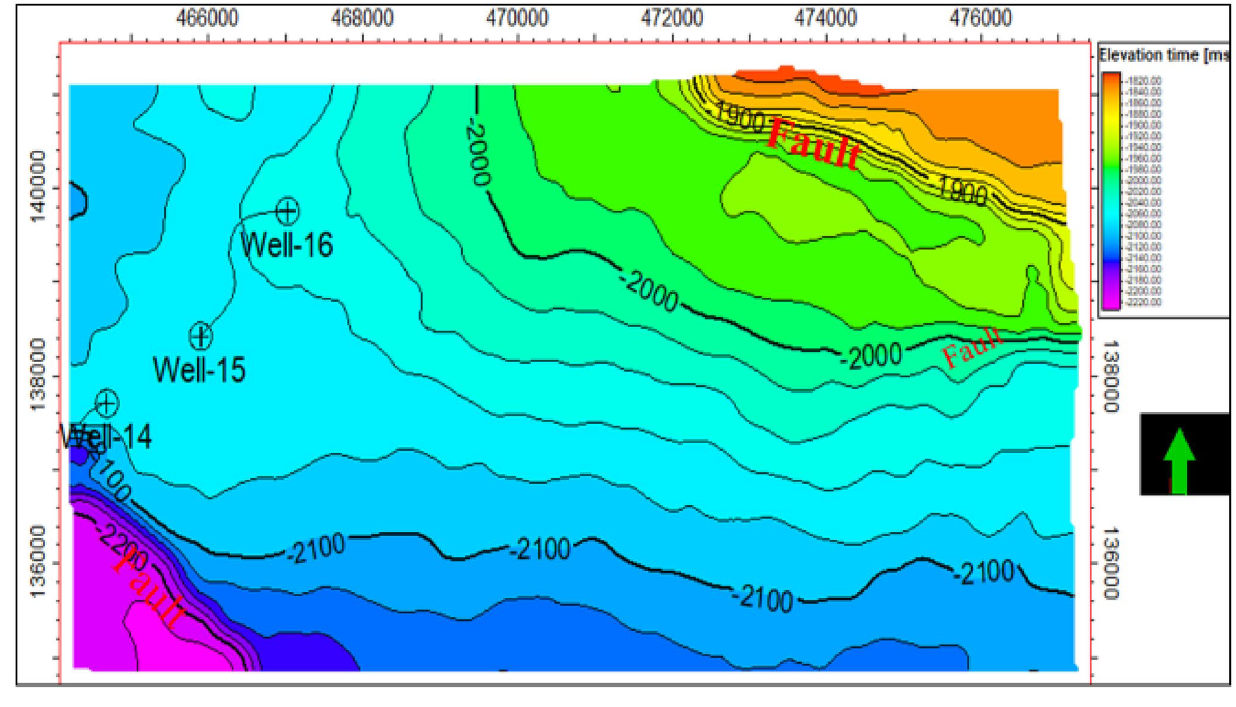
Fig. 8 Time structure map along H4